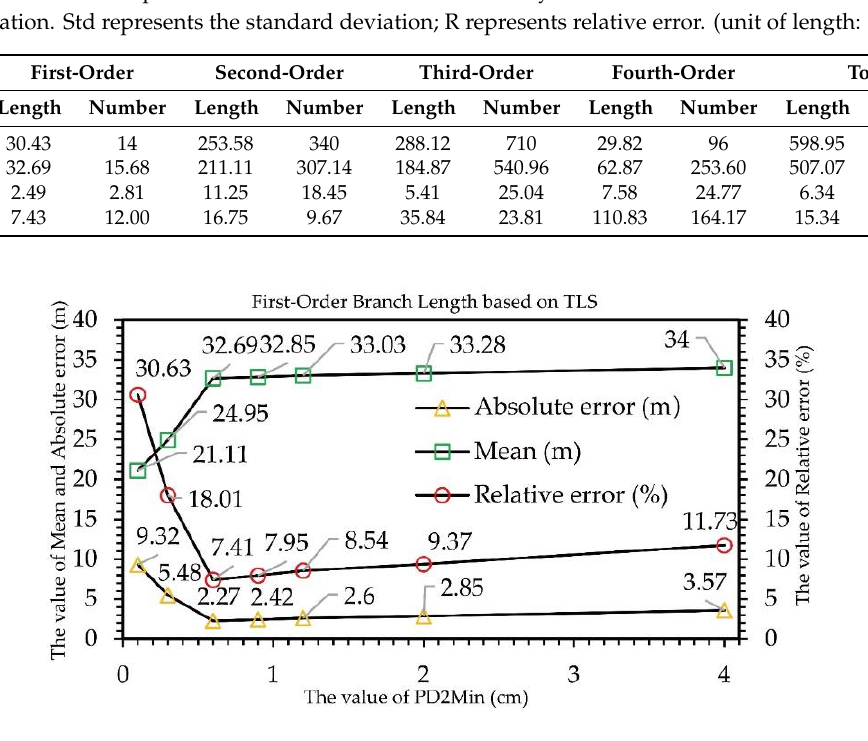
Figure 5. Uncertainty analysis of parameter PD2Min based on TLS. The best value of PD2Min is 0.6 cm for the TLS cloud point. PatchDiam1, PatchDiam2Min, and PatchDiam2Max are abbreviated as PD1, PD2Min, and PD2Max, respectively.